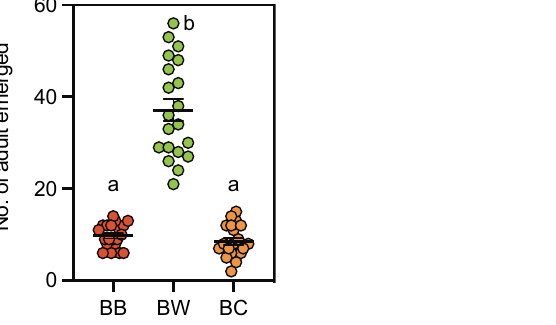
Figure 1. Field preference of gravid wax moths to beehives . Gravid female wax moths preferred and laid significantly more eggs in the beehive without bees (BW) than onto beehives with bees (BB) or with conspecifics. Error bars represent s.e.m. Statistical difference was analyzed by one-way ANOVA. Letters indicate statistical differences derived from One-way ANOVA analysis and Tukey’s multiple comparison post hoc